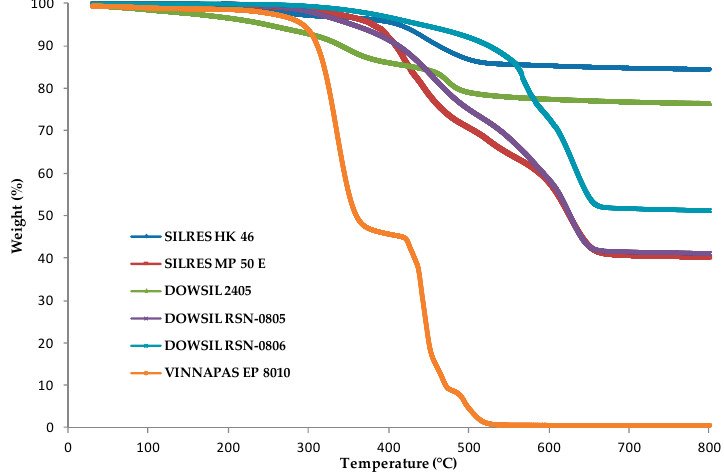
Figure 2. TGA (Thermogravimetric analyses) curves of commercial polymerized binders showing the weight loss as a function of the temperature (°C). Table 1. Temperature of the first weight loss observed for the polymerized commercial binders by TGA.